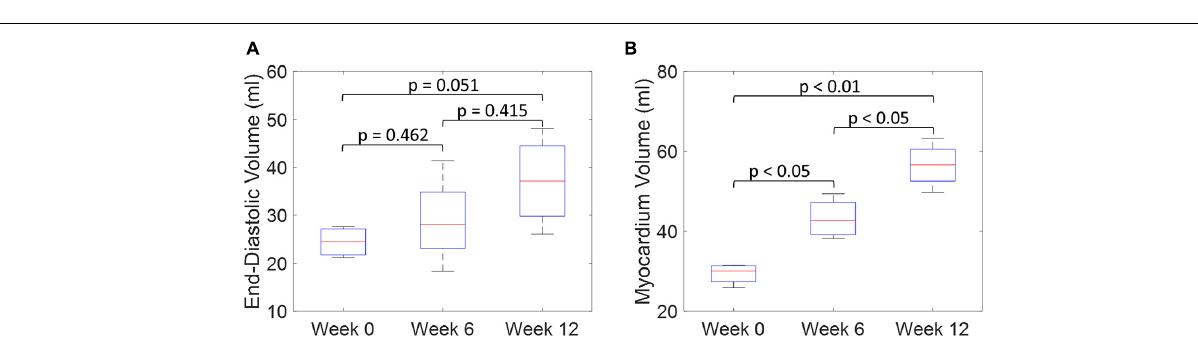
FIGURE 8 | Quantitative comparisons of LV end-diastolic volume (A) and myocardium volume (B) between weeks 0, 6, and 12 during exercise training. (Boxplots show median, interquartile ranges, and whiskers show range. P -values were calculated using standard t